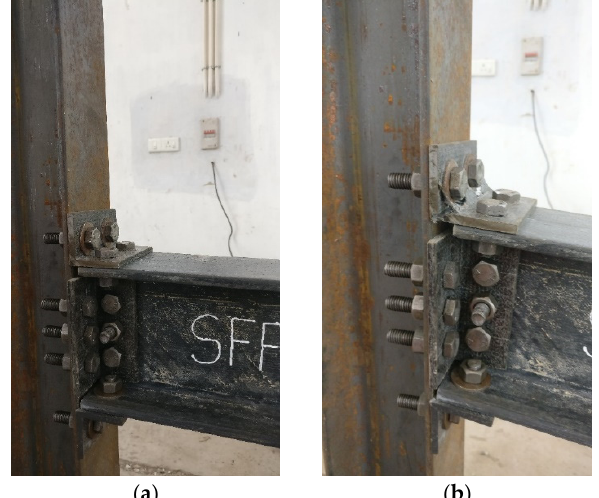
Figure 13. Delamination cracking in specimen SFFc2: ( a ) Undeformed joint; ( b ) Deformed joint.